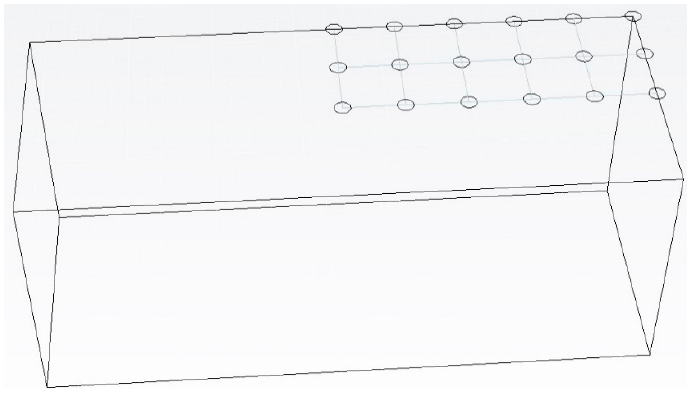
Figure 3. Sensor arrangement at the roof of the tank.